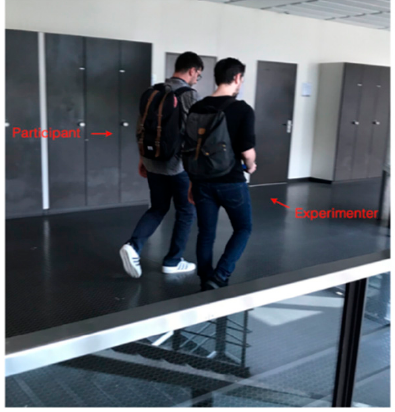
Figure 19. Participant fills in the questionnaire, after finishing experiment’s wayfinding task.